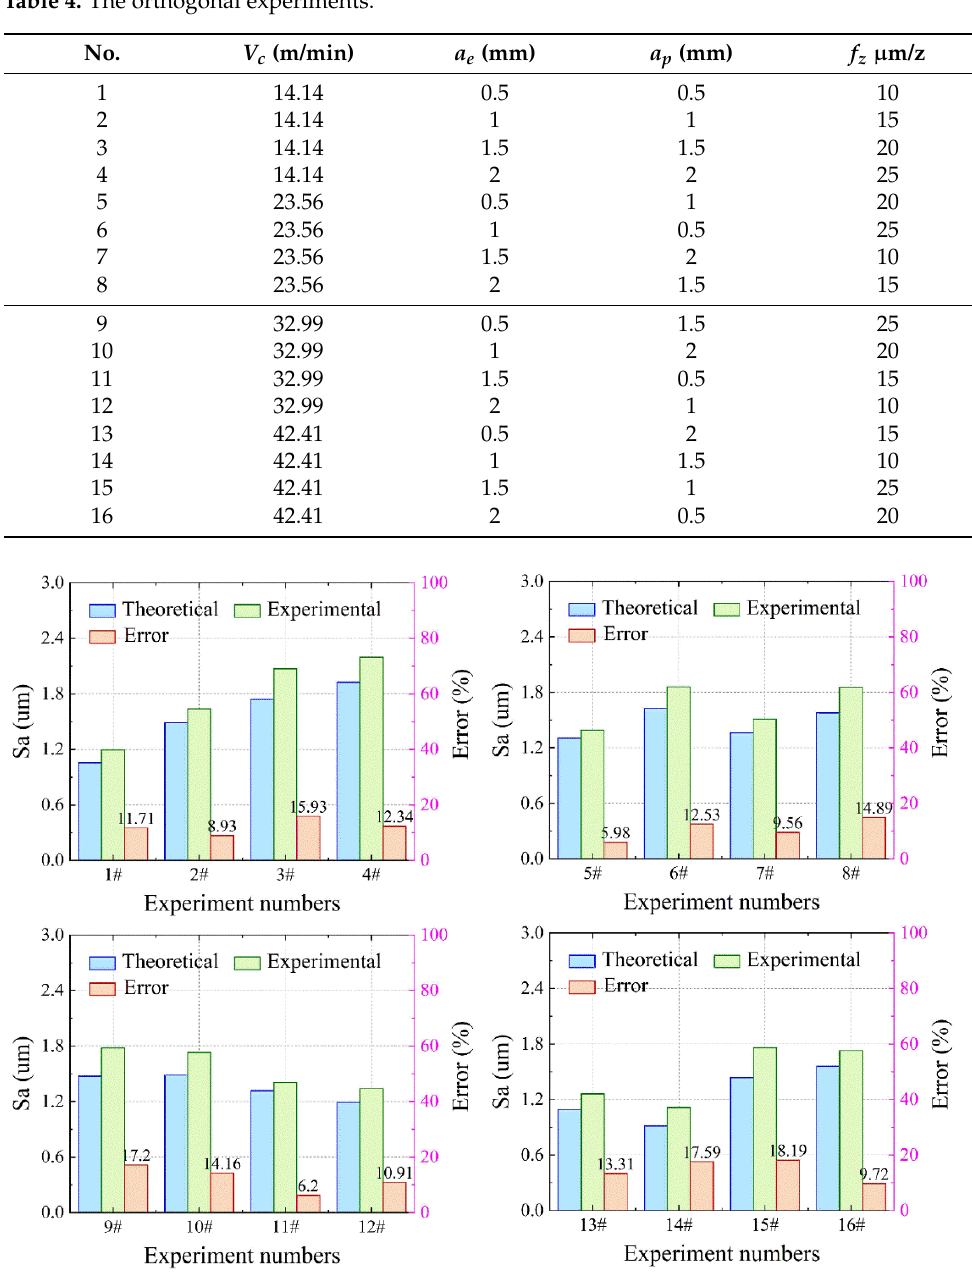
Figure 27. The comparison between the theoretical and experimental values.